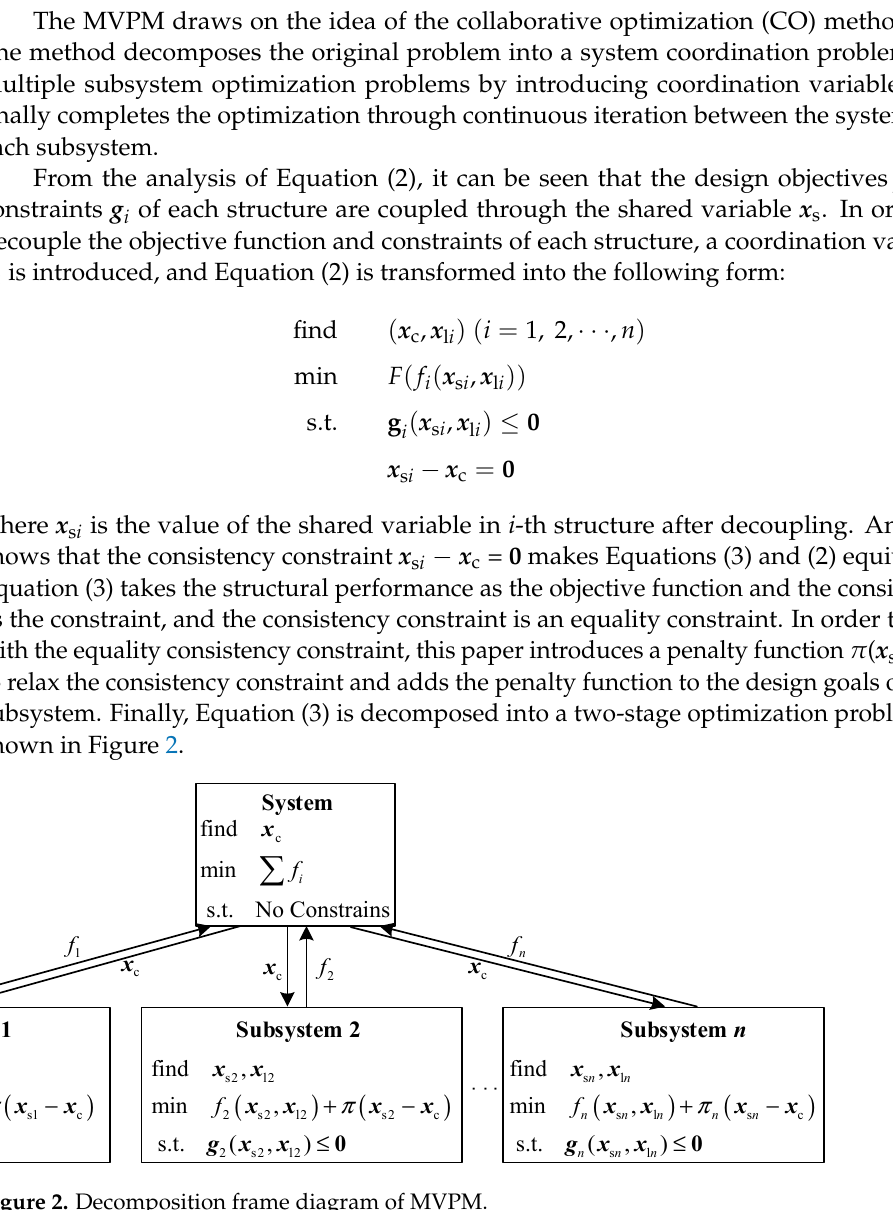
Figure 2. Decomposition frame diagram of MVPM.